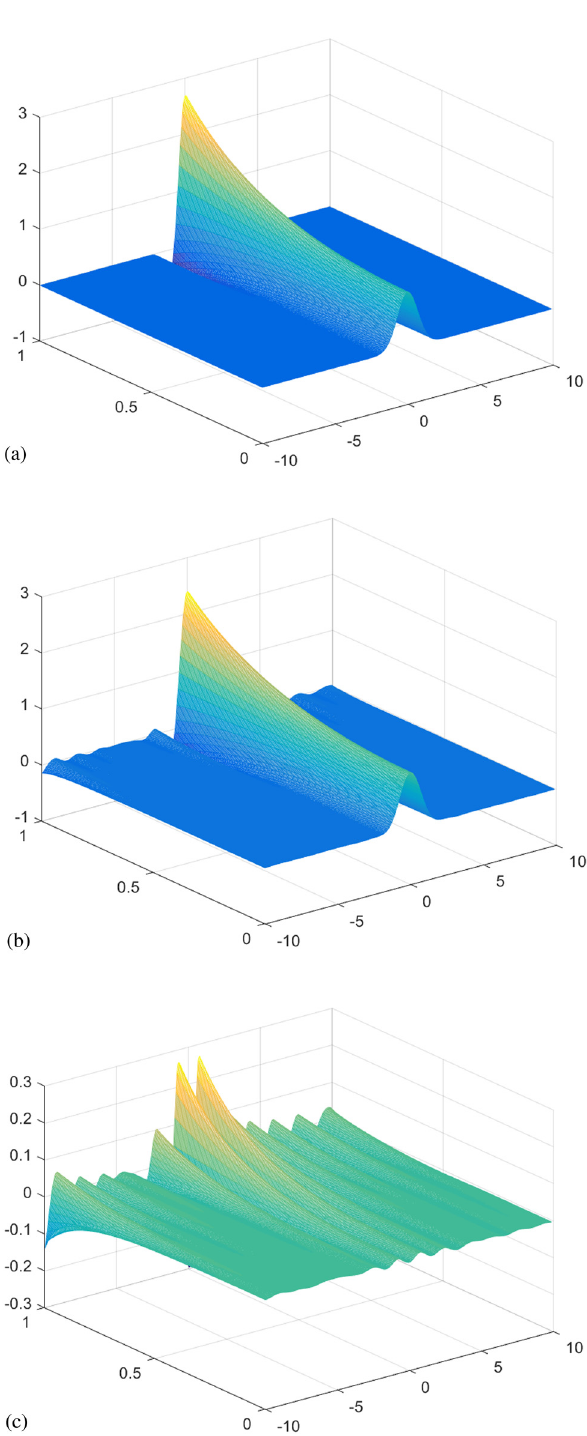
Figure 1: The exact solution, the regularization solution and error for δ 0.01 1 = ( Example 1 ) . ( a ) u x y , ( ) , ( b ) u x y , αδ ( ) , and ( c ) u x